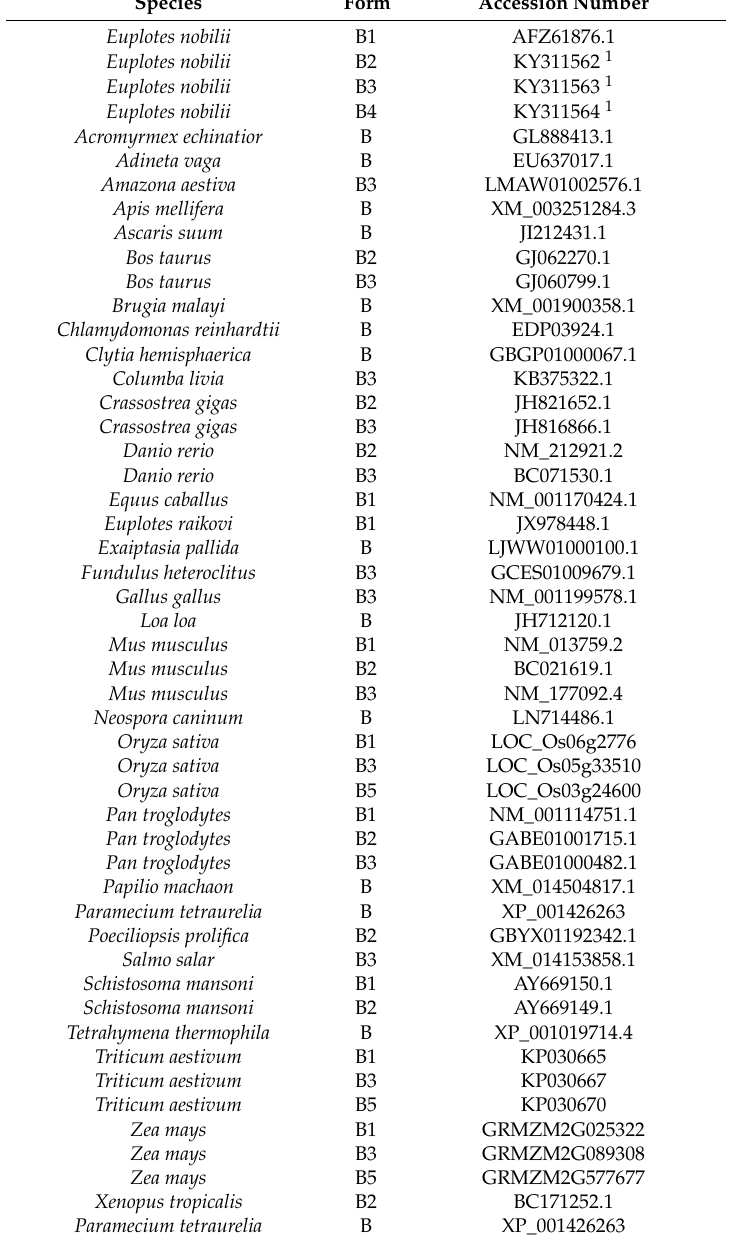
Table A1. MsrB proteins included in the phylogenetic analysis: Source, form and GenBank accession